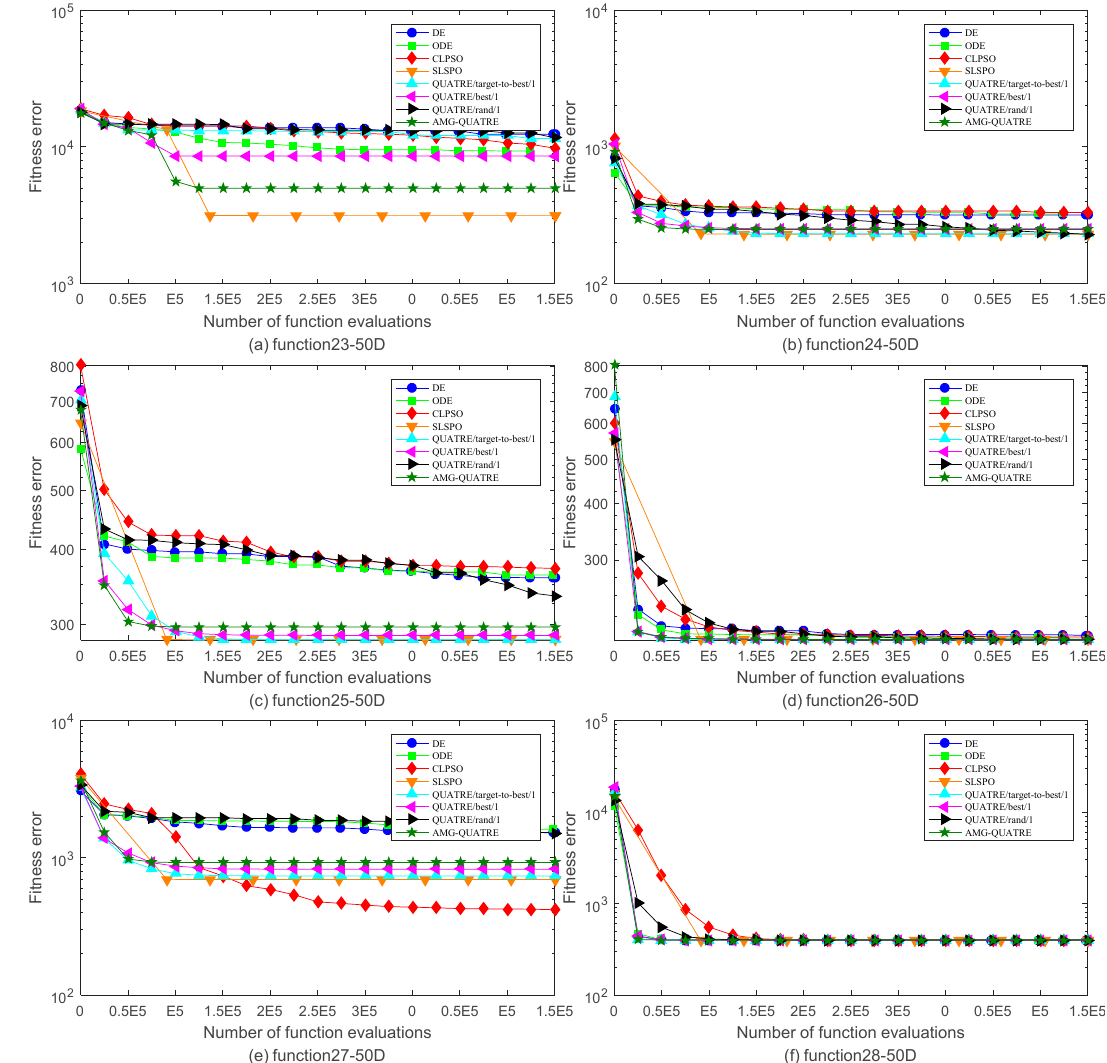
Figure 6. Comparison of the best of fitness errors for functions f 23 – f 28 with 50D optimization. ( a ) f 23 ; ( b ) f 24 ; ( c ) f 25 ; ( d ) f 26 ; ( e ) f 27 ; ( f ) f 28